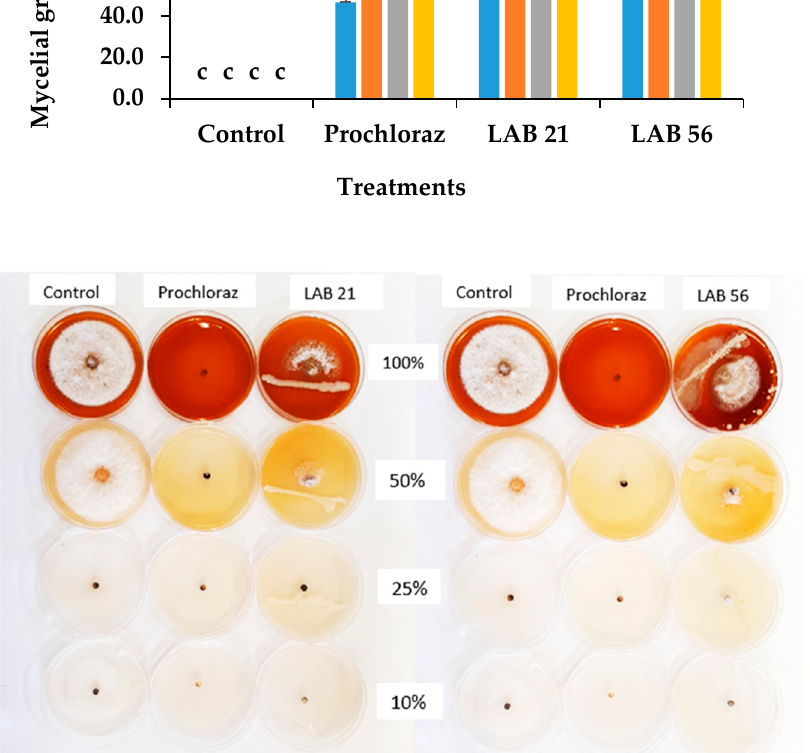
Figure 3. Effects of the LAB strains on nutrient competition and inhibition of C. gloeosporioides mycelial growth. Similar columns with the same alphabetic letter were not significantly different ( p ≤ 0.05). Keys: control—sterile distilled water; LAB 21— Weissella cibaria 21 ; LAB 56— Leu. pseudomesenteroides 56; PDM 100%—full strength (100%); PDM 50%—half-strength (50%); PDM 25%—one-fourth concentration (25%); PDM 10%—one-tenth concentration (10%).